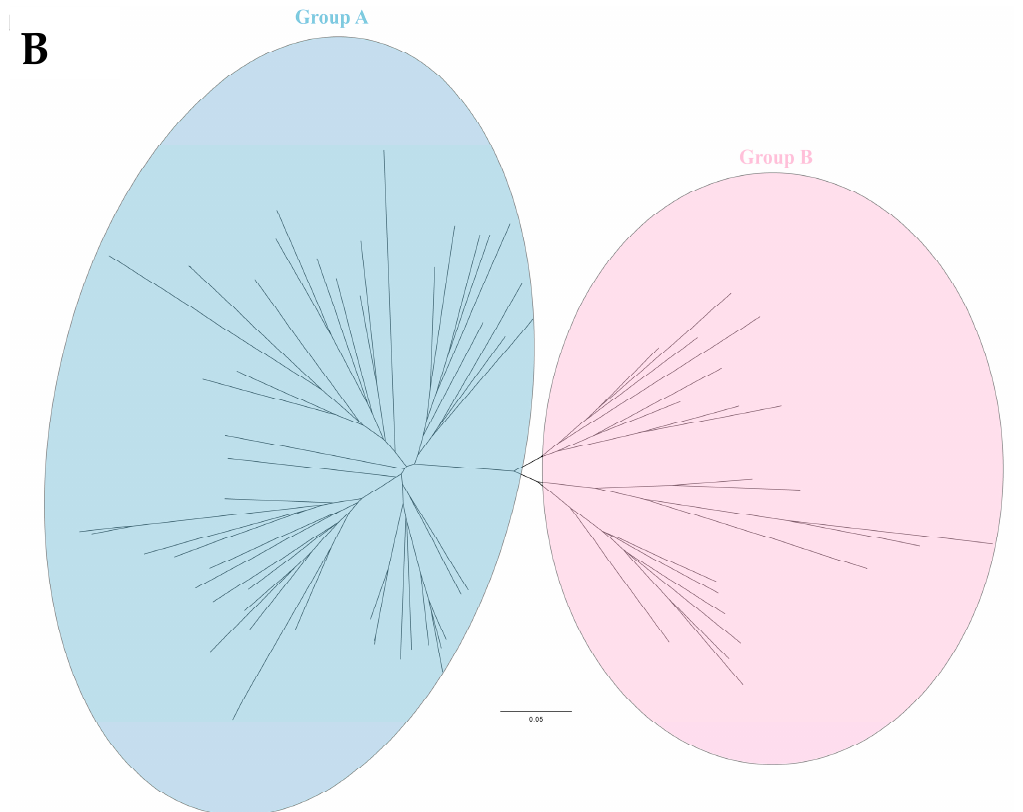
Figure 2. Recombination events of PKV. ( A ). The colored regions of each PKV indicate genetic recombination at the genomic sites with other Kobuvirus origin, and the location of the breakpoint is also marked. ( B ). Phylogenetic analysis of recombination regions based on the ML method; two different groups are marked with two different